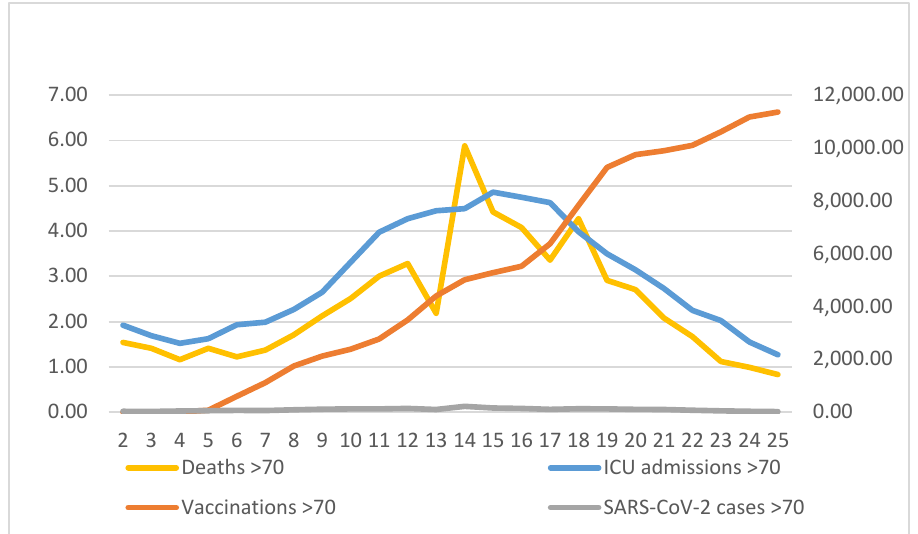
Figure 6. Average of vaccinations, weekly SARS-CoV-2 cases, ICU admissions and deaths for subjects >70 years. Data are expressed per 100,000 population. The left y axis corresponds to ICU admissions and deaths. The right y axis refers to vaccinations and SARS-CoV-2 cases.